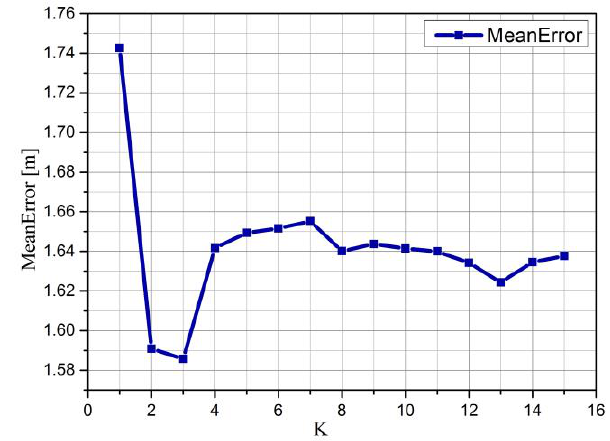
Figure 2. The K value’s impact on positioning.